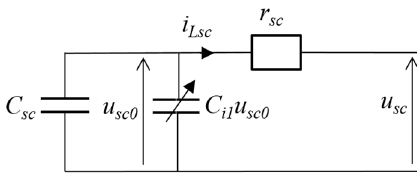
Figure 4. Supercapacitor model.